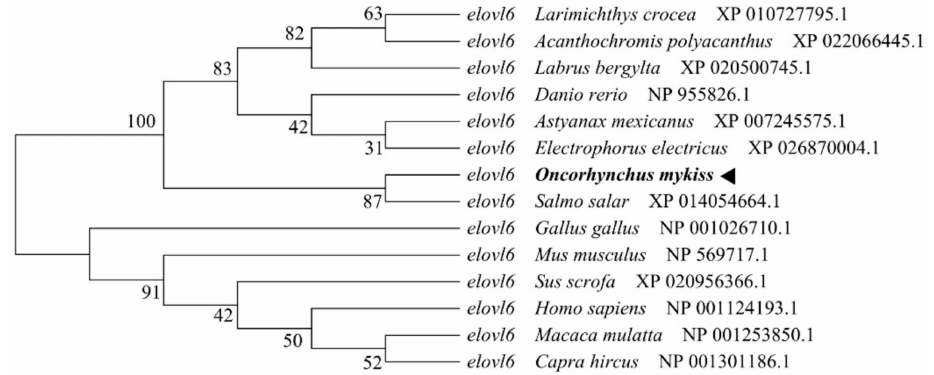
Figure 3. Phylogenetic tree of elvol6 in rainbow trout and other vertebrate counterparts. The neighbor joining method in MEGA6 was used to construct the tree. The numbers represent the frequencies (%) with which the tree topology presented was replicated after 1000 iterations.